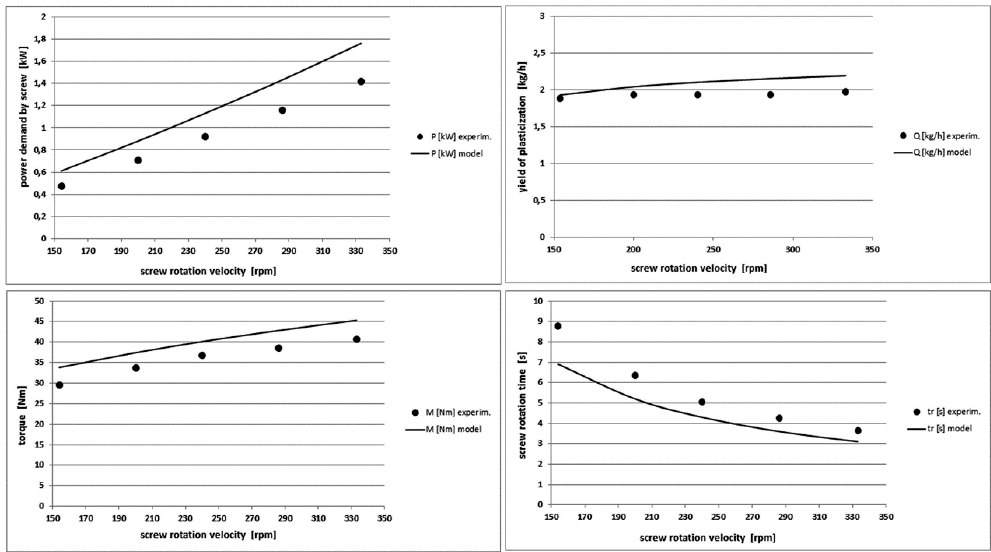
Figure 11. Comparison of other theoretical and experimental characteristics for different screw rotational velocity values in PE-LD injection process.